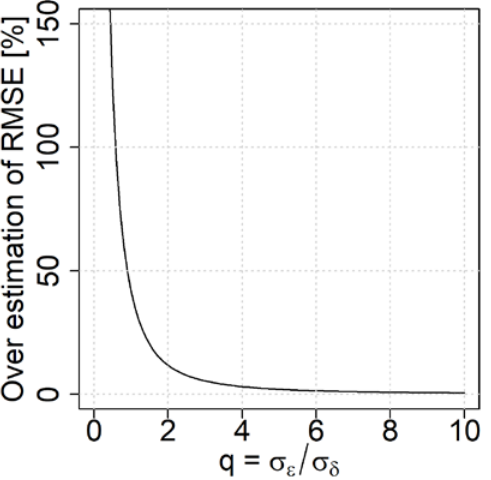
Figure 4. Illustration of how the RMSE for the RS-based estimates is overestimated for di ff erent values of q.